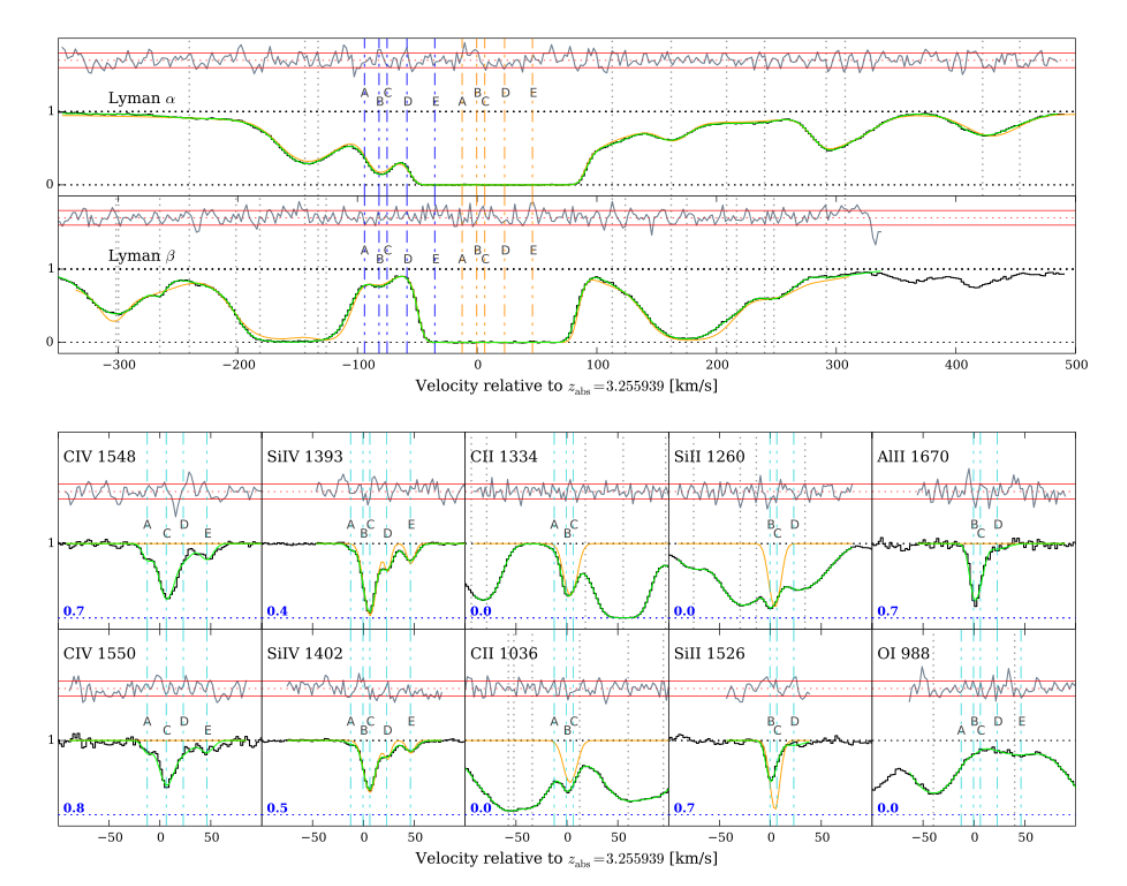
Figure 2. The normalised stacked flux spectrum (thick black) of the z abs = 3.256 absorber, and the best fit model (green), as well as the normalised fit residuals (above each fit). The stacked spectrum is only used for visualisation, as the model fitting is always performed on the individual spectra simultaneously. The fitted velocity components are marked by vertical dot-dashed lines denoted by A to F (HI in orange, DI in blue, metals in cyan), and interloping HI lines are shown as vertical dotted lines (light grey). It is seen that the structure of the absorber is more complicated than the old model from Crighton et al. [7] (orange), which has a significant impact on the final result. Figure from